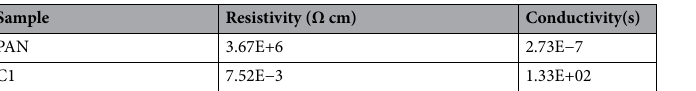
Table 3. Hall-effect measurement results of PAN and carbon fibers carbonized at 1000